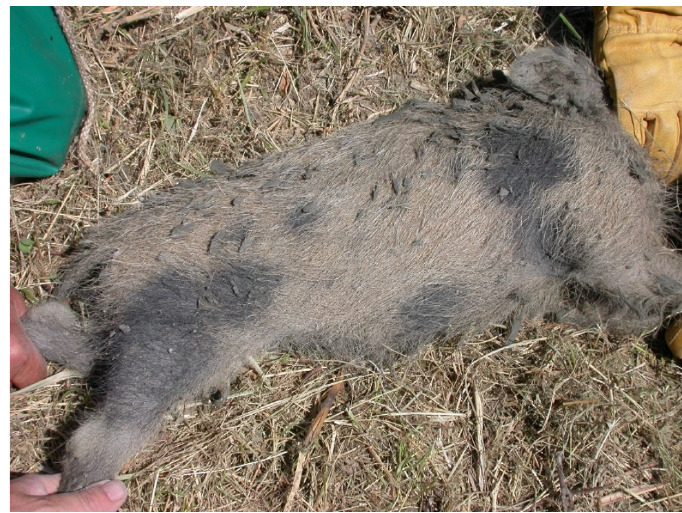
Figure 3. Free-ranging suid captured in the Gessi Bolognesi e Calanchi della Abbadessa Regional Park showing a typical hybrid morphological (spotted) phenotype.